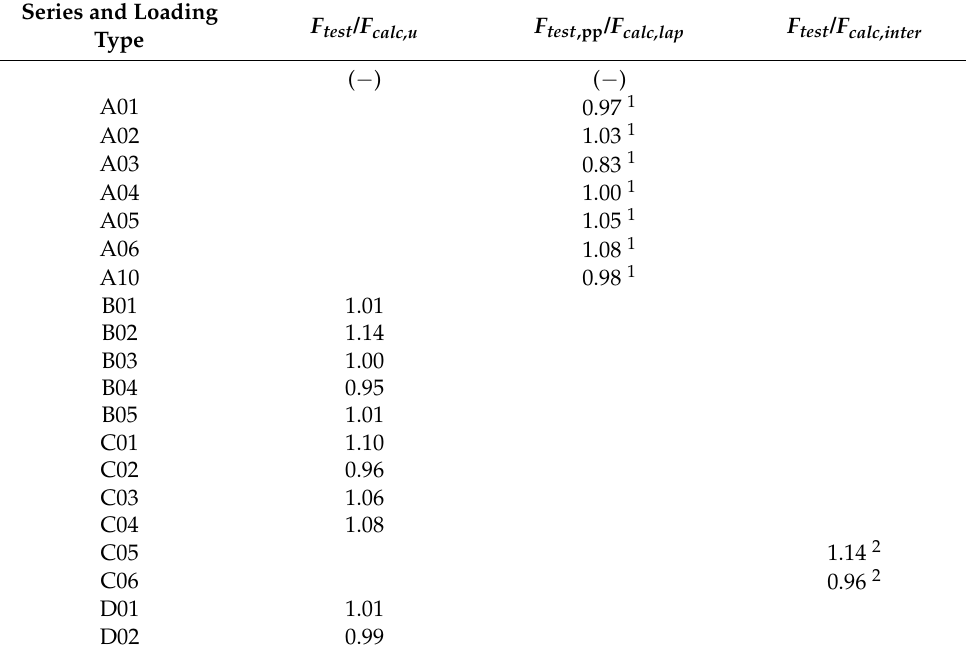
Table 4. Ratio of values obtained during the test and calculated loads based on bending or forces developed at the interface (in